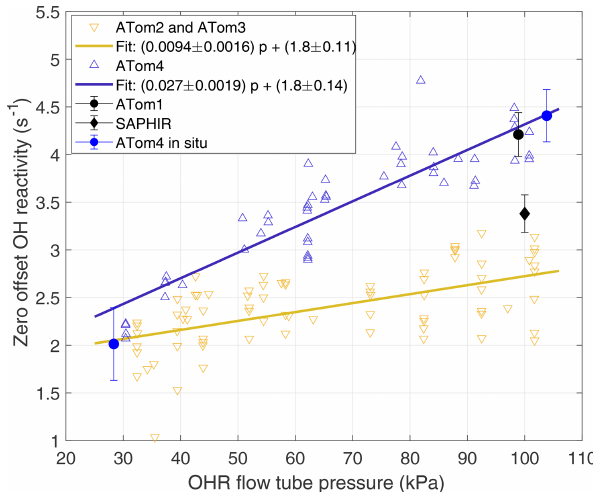
Figure 2. Laboratory and in situ calibrations of OHR offset over 1min sums. The offset was calibrated only at ∼ 100kPa around ATom1 in 2015 and 2016 (black dot). The offset was measured with a slightly different instrument configuration during the OH reactiv- ity intercomparison study in 2015 (black diamond) (Fuchs et al., 2017). Shown are offset calibrations performed in 2017 between ATom2 and ATom3 (yellow inverted triangles) and their linear fit (yellow line), in 2018 at the end of ATom4 (blue triangles) and their linear fit (blue line), and in flight (blue dots). Error bars are ± 1 standard deviation of the mean. The ATom4 fit was used for ATom1 because the high-pressure laboratory calibrations were essentially the